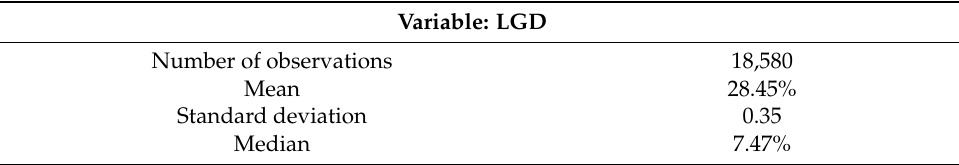
Table 12. LGD summary statistics of Country